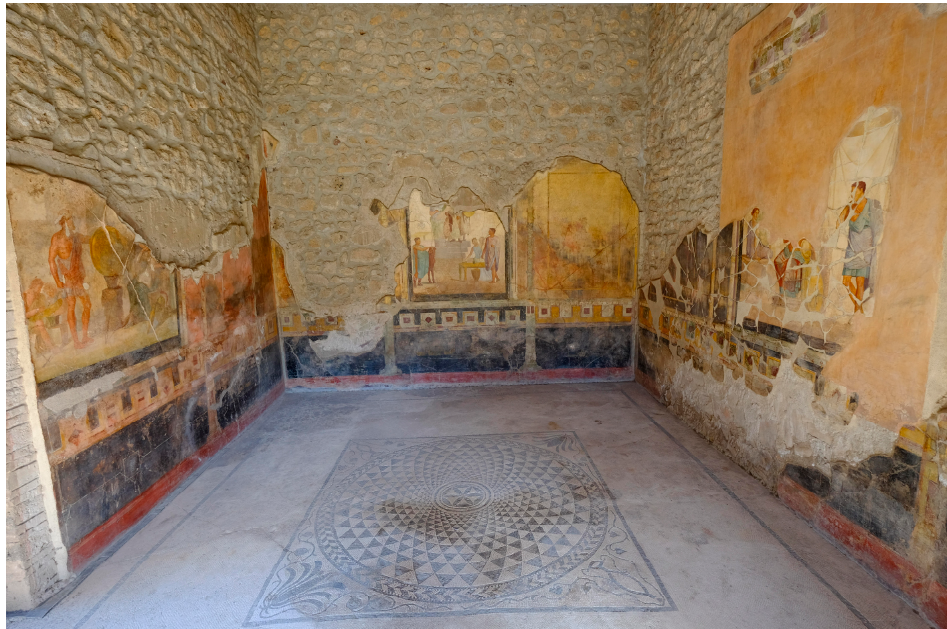
Figure 4. View into Room G from the peristyle, House of the Gilded Cupids, Pompeii. Robert Harding/Alamy Stock Photo. Used by permission.